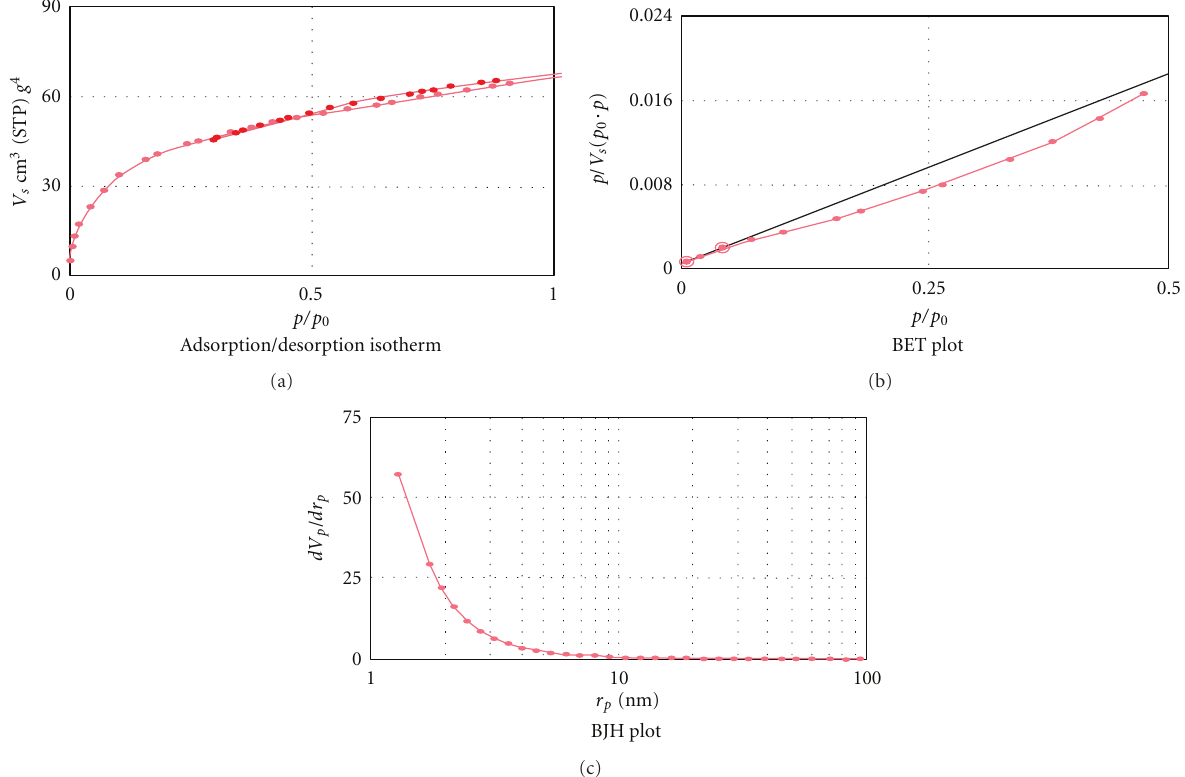
Figure 4: (a) Nitrogen Adsorption-Desorption isotherm for PNP-SBNPM, (b) BET-plot of PNP-SBNPM, (c) BJH average pore diameter diagram for